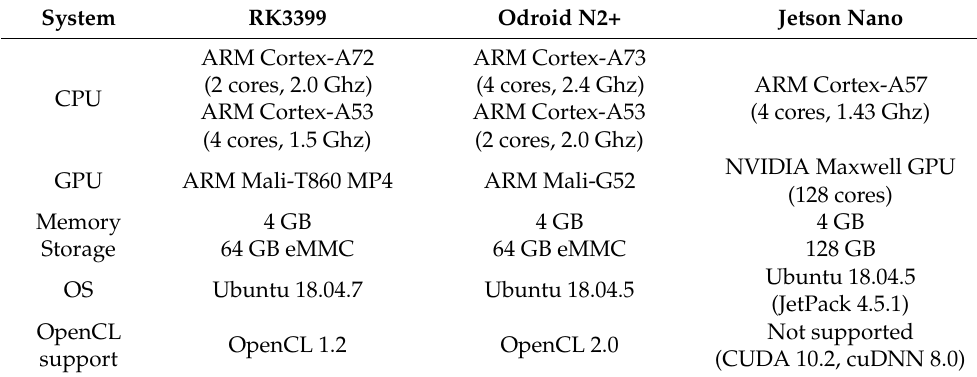
Table 4. Performance evaluation